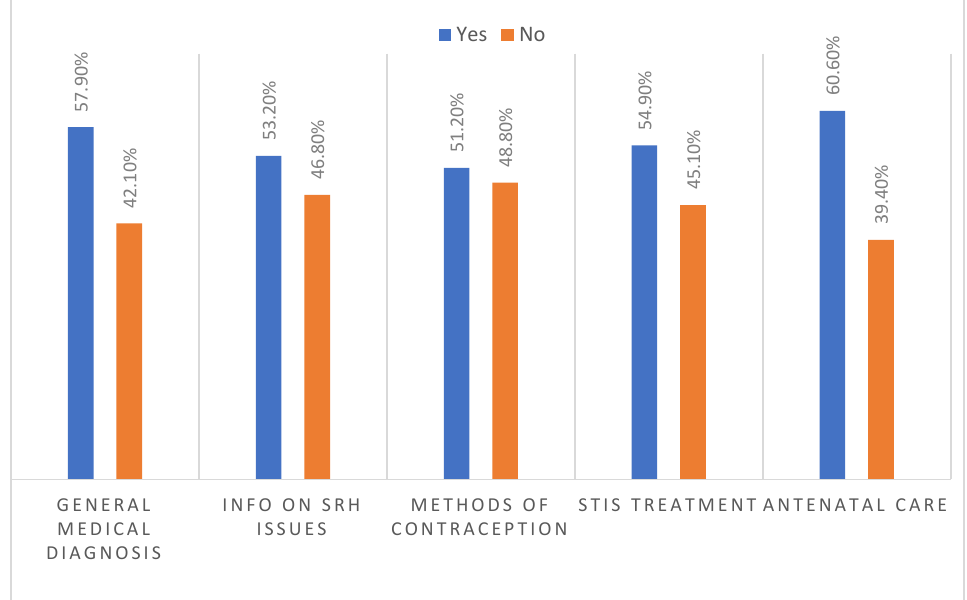
Figure 3. Awareness of the participants on available and accessible health services in Bourj Hammoud and its neighbouring urban areas.